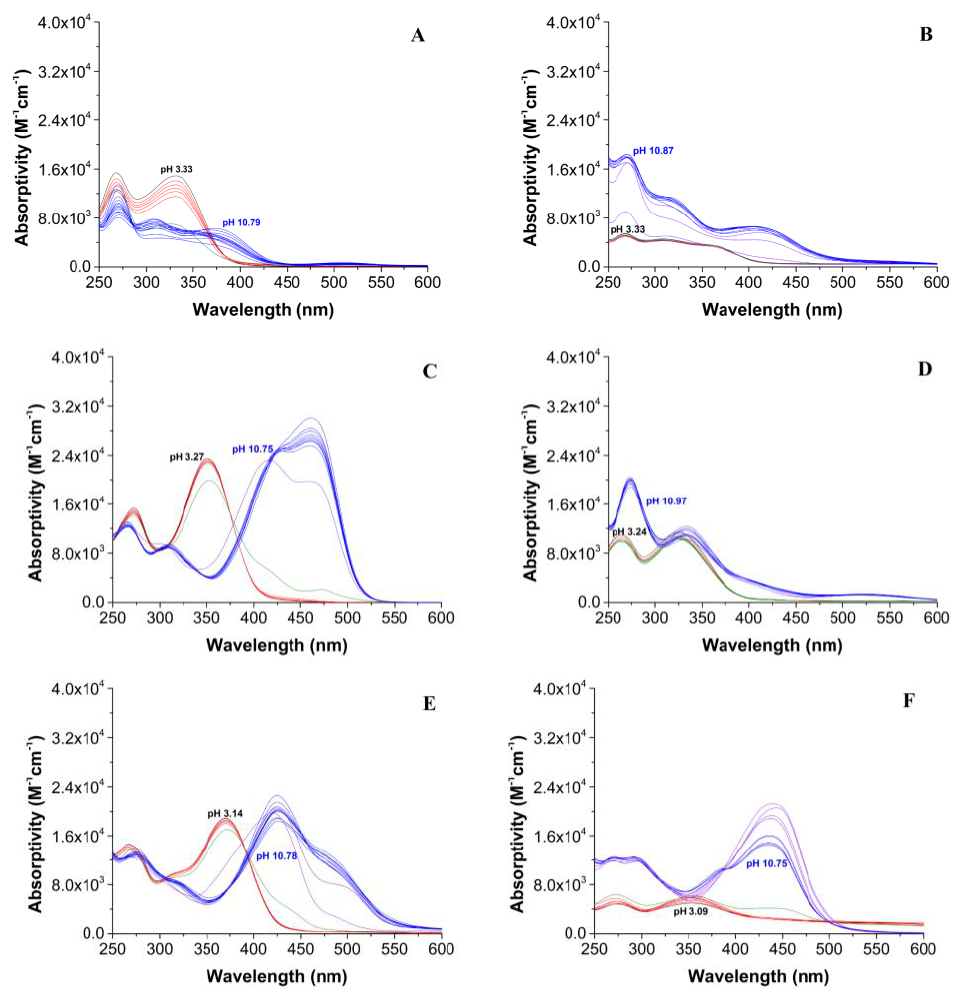
Figure 3. Selected spectra, reported as molar absorptivity, were collected during the potentiometric and spectrophotometric titrations of T1 − 6 ( A − F ) (25 °C, NaCl 0.1 M). Table 4. Protonation constants of T1 – 6 (25 °C, NaCl 0.1 M). The standard deviation to the last sig- nificant figure is reported in parentheses.